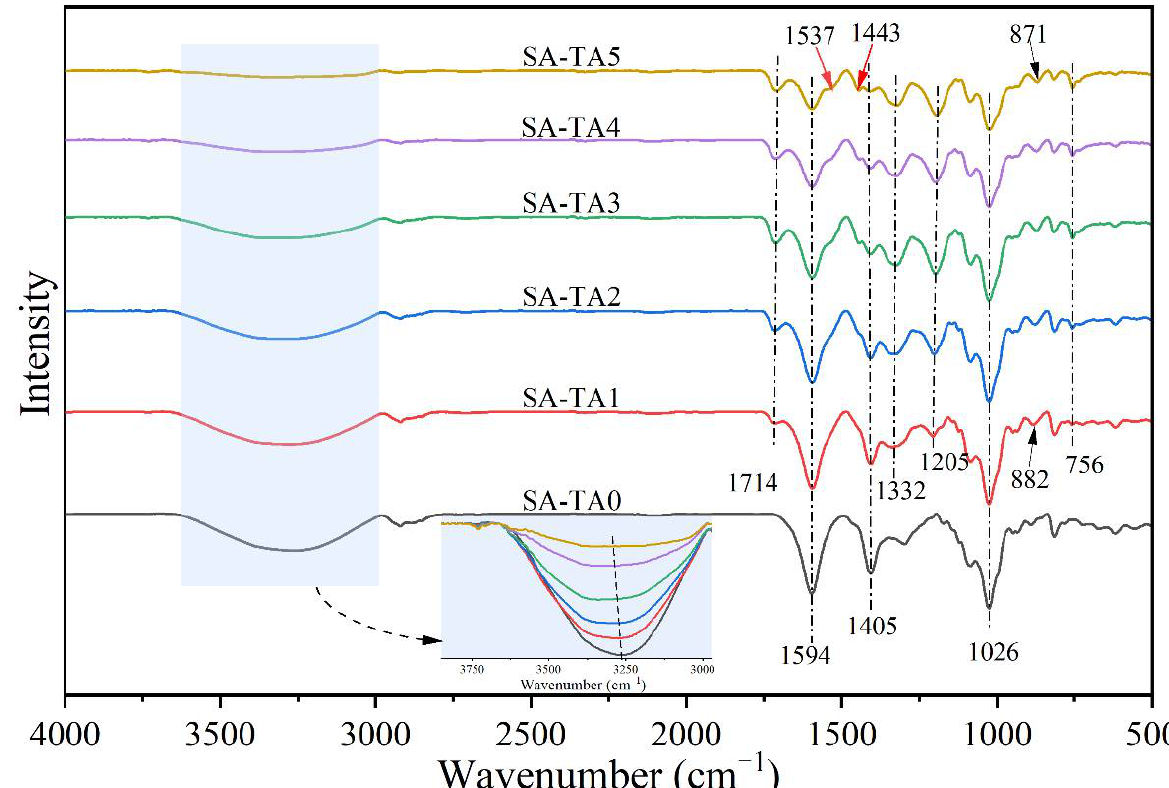
Figure 1. FTIR spectra of neat SA and SA-TA films.